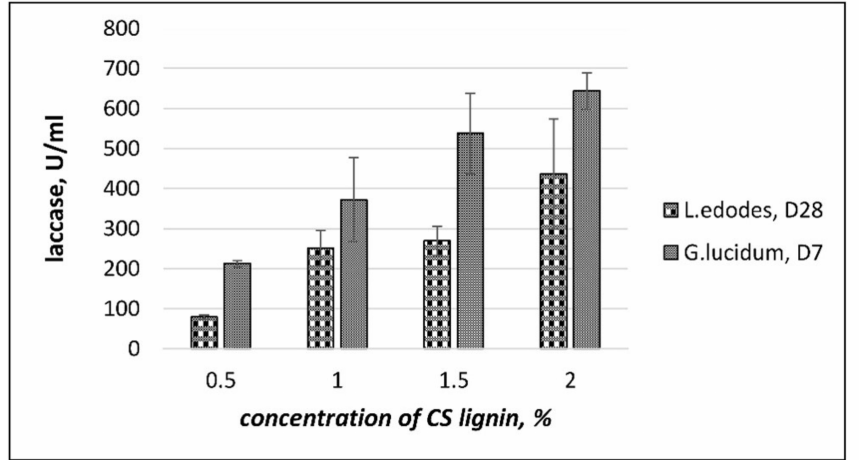
Figure 3. The effect of CS lignin on the accumulation of laccase activity during SM cultivation with agitation. D7 and D28—days of incubation. Values are means with standard errors (vertical bars). Under CS lignin-free conditions, L. edodes and G. lucidum produced only a small amount of laccase but did not produce peroxidases. The laccase activity in culture liquids of G. lucidum was greater than that for L. edodes (Figure